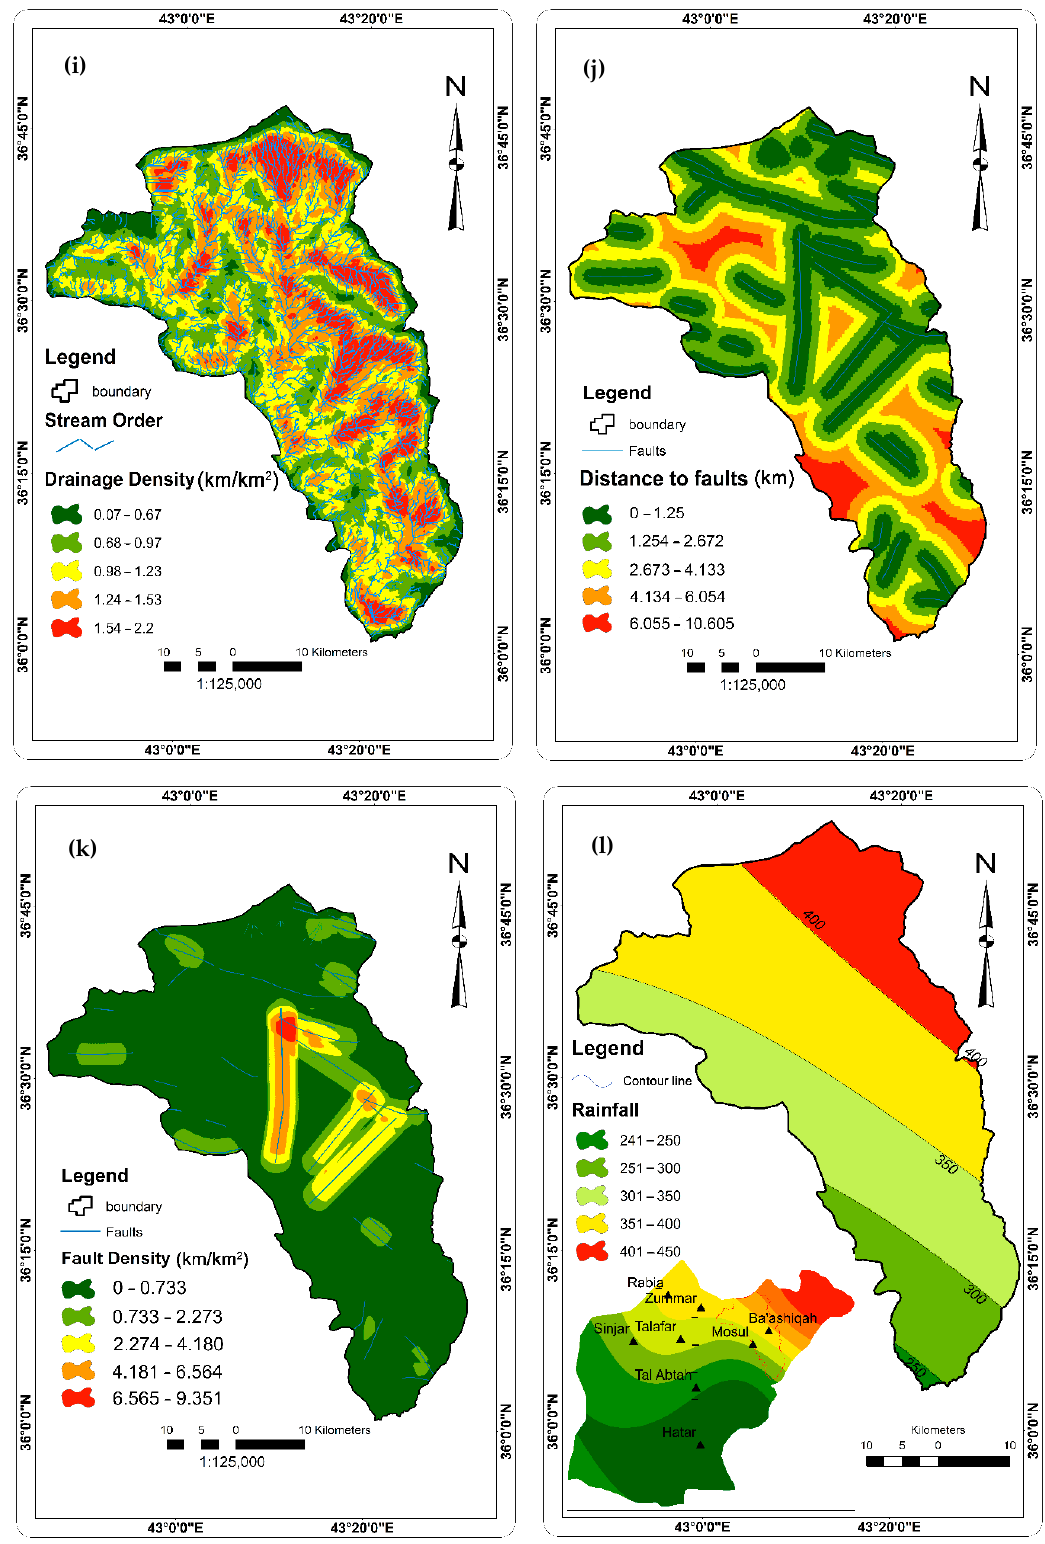
Figure 6. Aquifer-related factors: ( a ) depth to groundwater (m), ( b ) saturated thickness (m), ( c ) hydraulic conductivity (m/d), ( d ) transmissivity (m 2 /d), ( e ) specific yield ( f ), slope (%), ( g ) TWI, ( h ) SPI, ( i ) drainage density (km/km 2 ), ( j ) distance to faults (km), ( k ) fault density (km/km 2 ), ( l ) annual rainfall